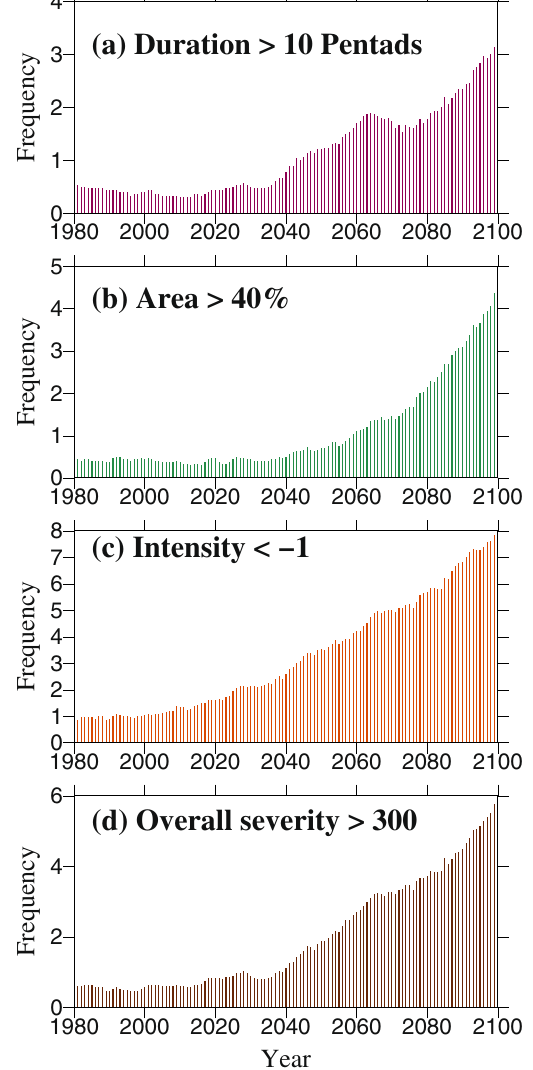
Fig. 4 Flash drought projections in India under the projected future climate using CESM-LENS ensemble. a 30-year moving mean frequency of fl ash drought with duration more than 10 pentads during 1951 – 2100, b same as a but for the fl ash drought that had areal extent more than 40%, c same as a but for the fl ash drought that had mean intensity less than − 1, and d same as a but for the fl ash droughts that had overall severity score more than